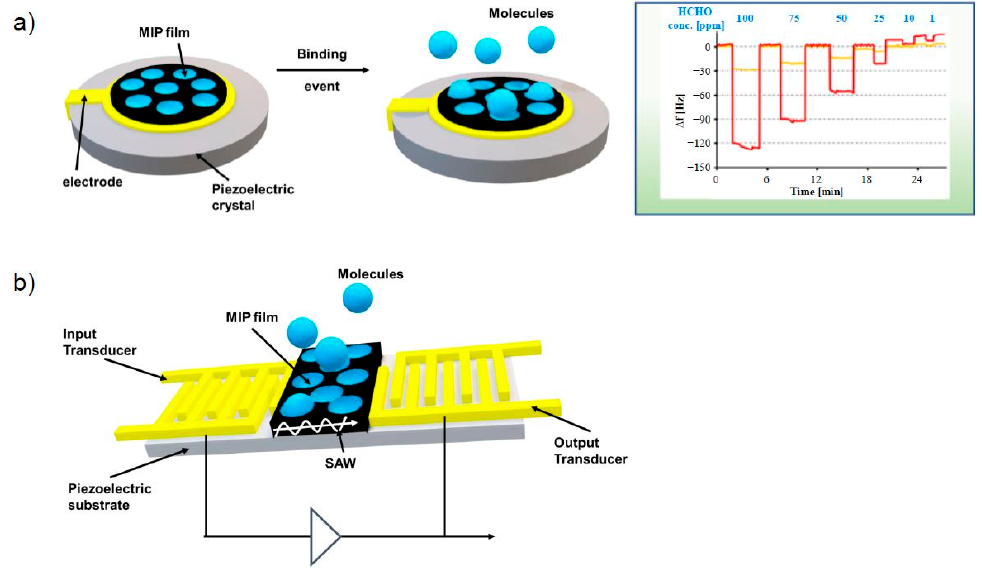
Scheme 2. ( a ) Scheme of a quartz crystal microbalance (QCM) chip coated with a MIP film (left) and a typical QCM response (right) for a MIP thin film (red), as well as the non-imprinted polymer (yellow) at different vapor concentrations of formaldehyde (in blue on the top of the graph). The difference between the red and yellow curves is attributed to the mass effects induced by the incorporation of the analyte into the recognition sites of the polymer film. The time-phase evolution corresponds to the change in formaldehyde concentration. Response graph taken with permission from [86]. ( b ) Scheme of a surface acoustic wave (SAW) sensor.